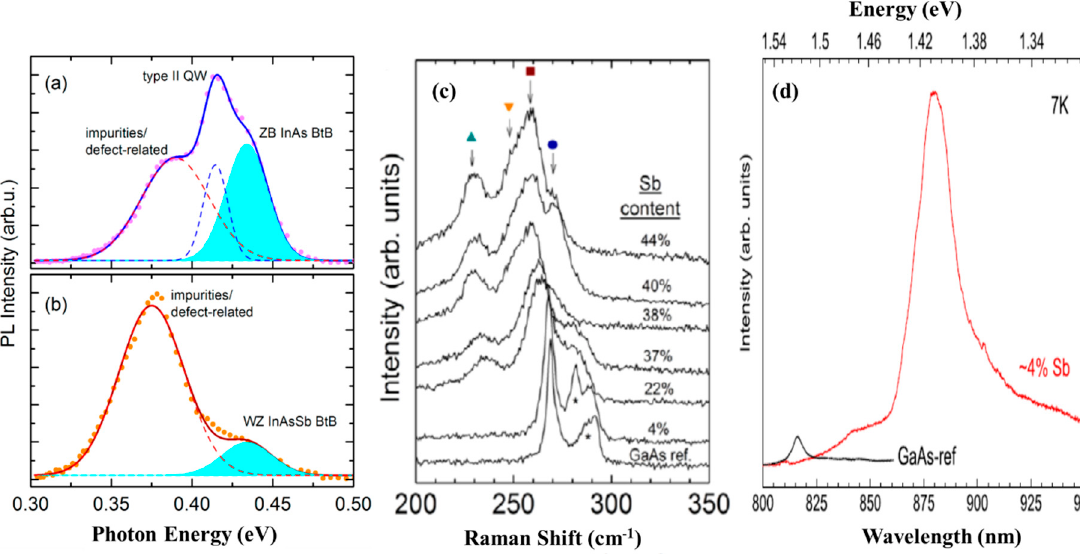
Figure 9. 10 K PL spectra of ( a ) InAs NWs showing three emission peaks associated with impurity/defect related, type II quantum wells (QWs) formed from the ZB and WZ crystal phase mixtures and ZB InAs band to band (BtB) transitions and ( b ) InAs 0.96 Sb 0.04 NWs which clearly exhibits a band-to-band (BtB) associated emission from WZ phase without the presence of type II QW emission, which indicates the quasi-pure WZ phase in the InAsSb NWs. Reproduced with permission from [53]; Copyright 2015, American Chemical Society. ( c ) Room-temperature Raman spectra of GaAsSb nanowires on a silicon substrate with increasing Sb content. The spectra are shifted for clarity. Alloy modes are marked by symbols and SO modes by an asterisk. ( d ) Photoluminescence (PL) spectrum of the GaAsSb NWs with the lowest Sb content in this work. The PL of GaAs reference NWs grown with the same system is also shown. Reproduced with permission from [59]; Copyright 2013, IOP publishing Ltd.